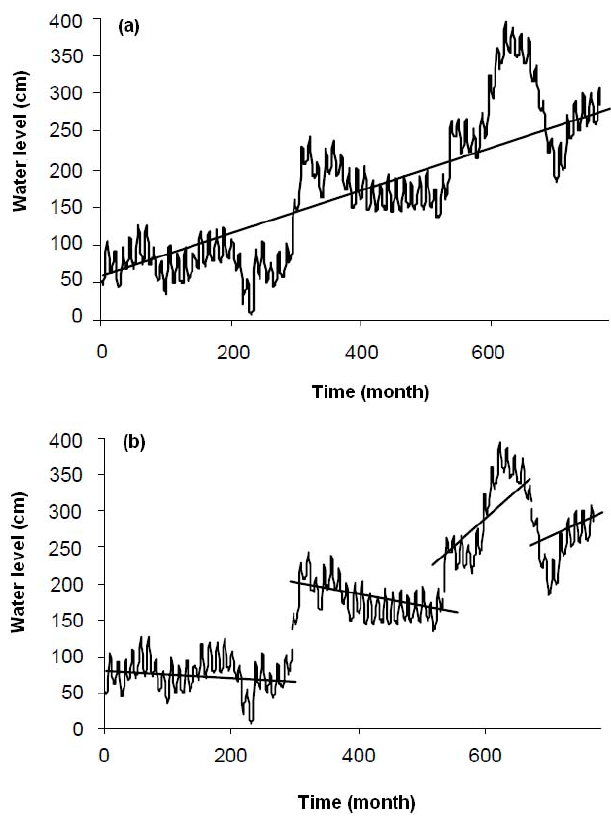
Fig. 4. Lake water level time series fitted by (a) mono-trend line, and (b) multiple-trend